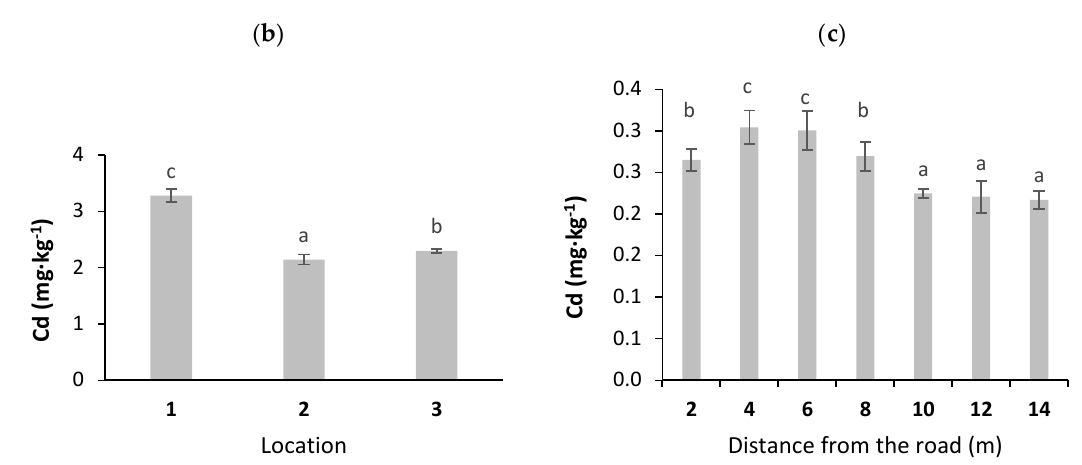
Figure 6. Cadmium concentrations in moss ( P. schreberi ): ( a ) distance from the road at sampling location, ( b ) average Cd content at di ff erent locations, and ( c ) Cd content at di ff erent distances from the road (average values from three locations) ( n = 5, ± standard deviation). Di ff erent letters above bars representing lead concentrations for di ff erent locations or for di ff erent distances from the road indicate that they di ff ered significantly (Tukey’s test, p < 0.01).